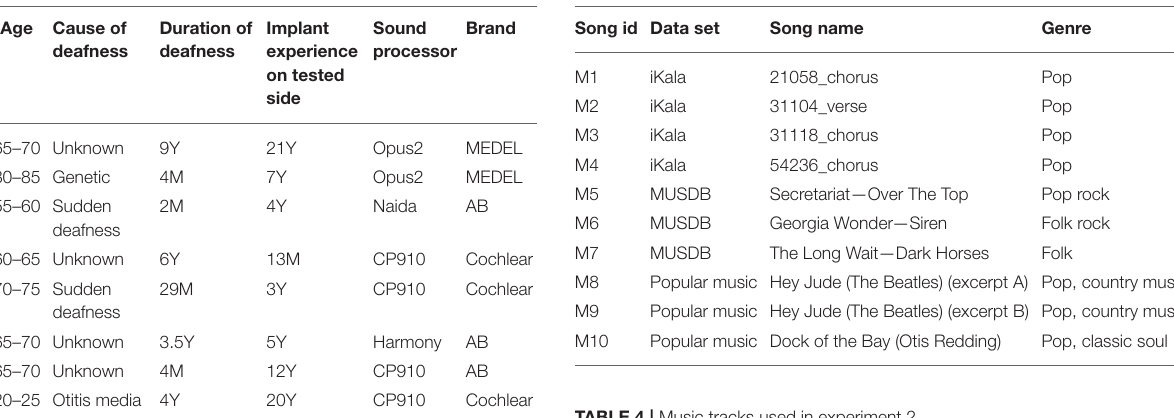
TABLE 2 | Information of the CI subjects, who took part in the experiments. TABLE 3 | Music tracks used in experiment 1.